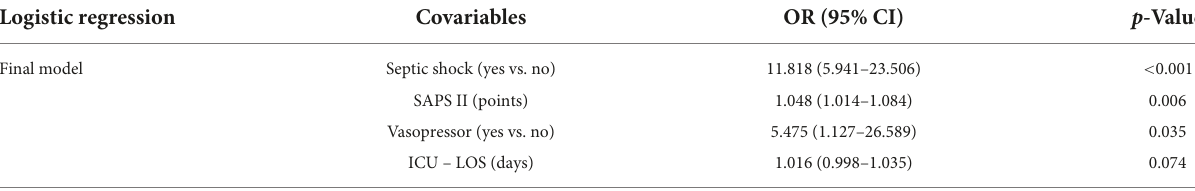
TABLE 5A Logistic regression model for factors associated with requirement of kidney replacement therapy. Logistic regression